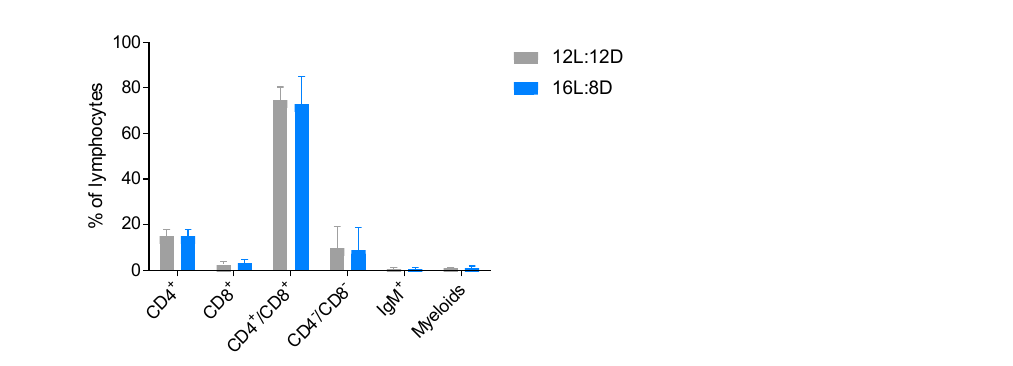
Figure 4. Effect of two different photoperiodic regimes on rainbow trout thymus . ( a ) Thymus weight; ( b ) total cell count of thymus; ( c ) weight of fish used for the experiment. The values are expressed as means ± SEM; n = 5. The statistical test used was Mann-Whitney, with p ≤ 0.05 considered significant. Statistical differences are represented by asterisks.